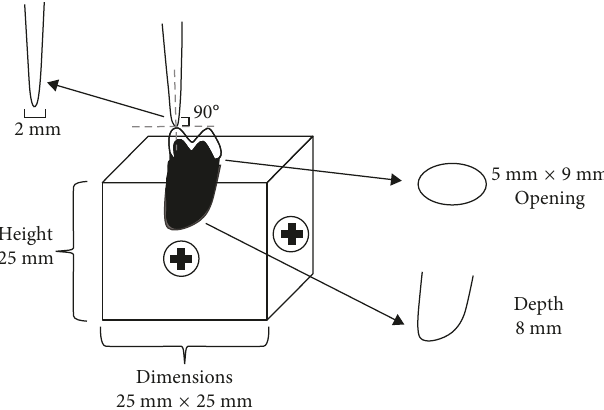
Figure 7: Schematic diagram of metal tooth analog-crown-metal jig assembly.